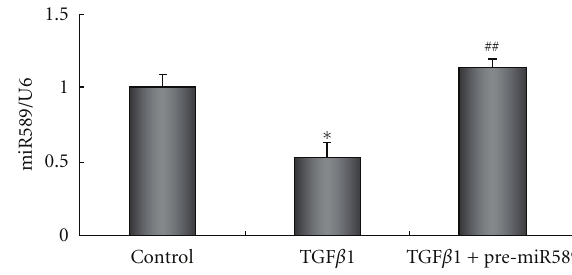
Figure 3: E ff ect of pre-miRNA589 on expression of miR589 in HMrSV5 cells following exposure to TGF β 1 (5ng/ml, 24 hr). The bar graphs show the 2 − ΔΔ C T value of miRNA589 relative to that of U6 in each group. The level of miRNA 589 was decreased in HMrSV5 cells treated with TGF β 1. (column 2), and this e ff ect was abolished following transfection with pre-miR589 (column 3). ∗ P < 0.05 versus control group, ## P < 0.01 versus TGF- β 1 treated